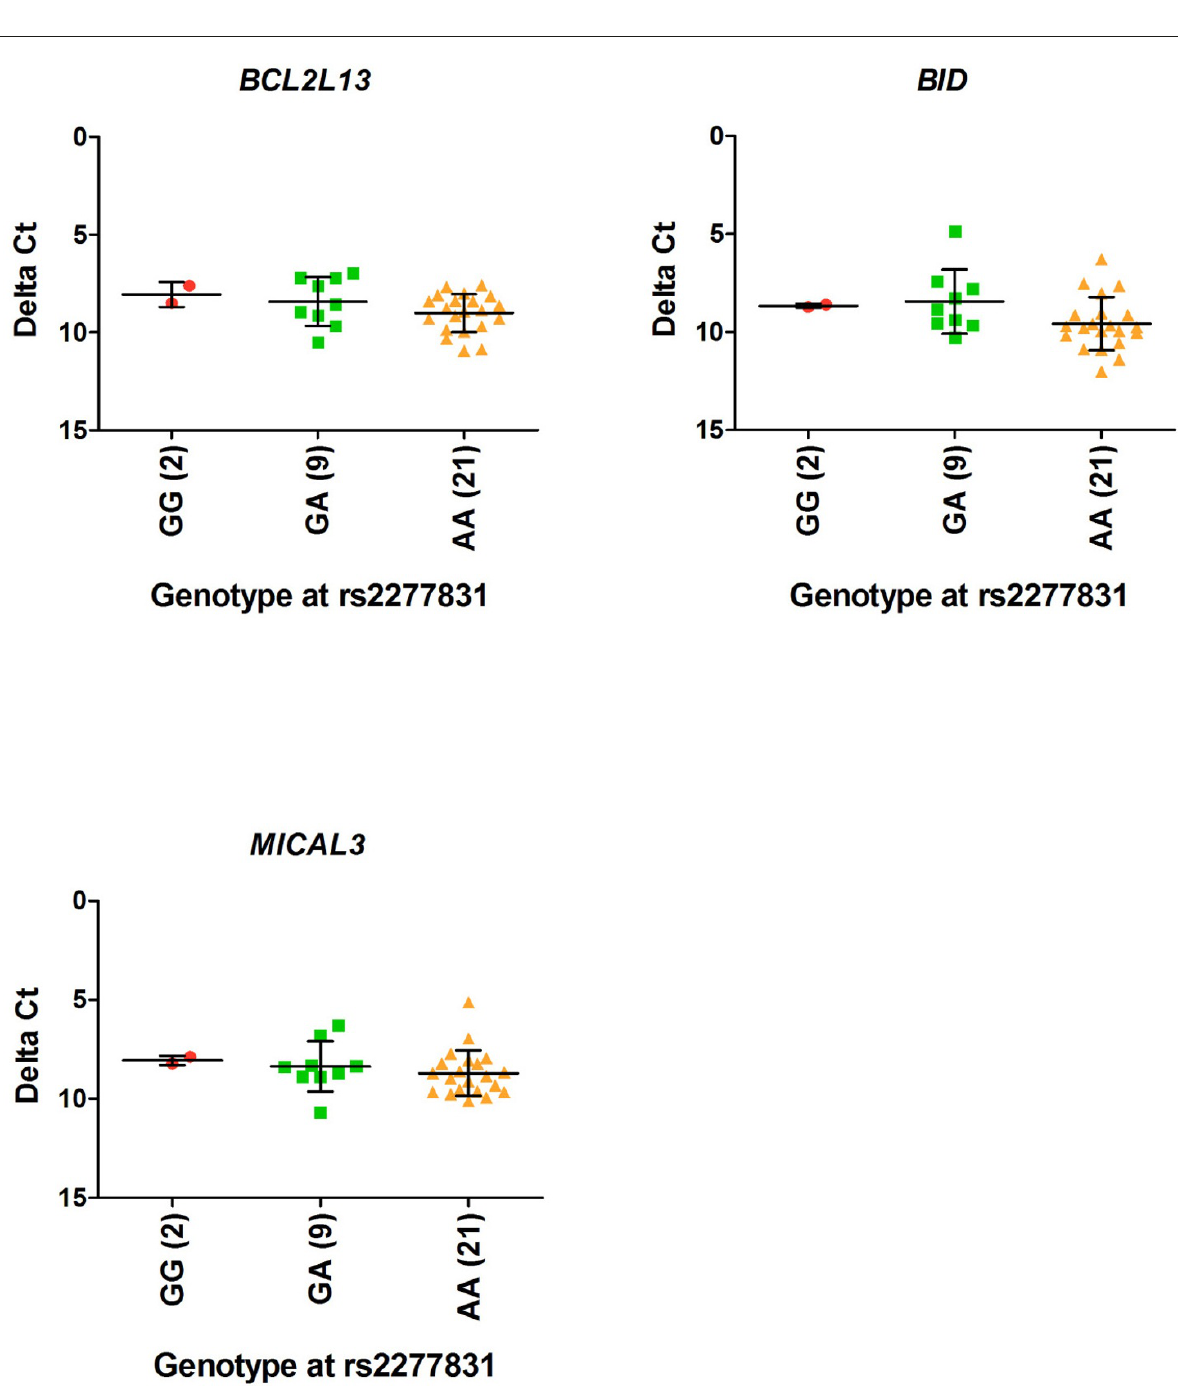
Figure 2 Expression in the cartilage of 32 OA patients of BCL2L13, BID and MICAL3 stratified by genotype at the OA associated SNP rs2277831 . The data points represent the average of the three replicates for each sample. The expression of (A) BCL2L13 , (B) BID and (C) MICAL3 was compared to the average of the housekeeping genes and the delta Ct values were plotted against the genotype at the associated SNP rs2277831. The horizontal bars represent the mean plus the standard deviation. The genotype at rs2277831 did not correlate with gene expression with P-values of 0.09 for BCL2L13 , 0.07 for BID and 0.33 for MICAL3